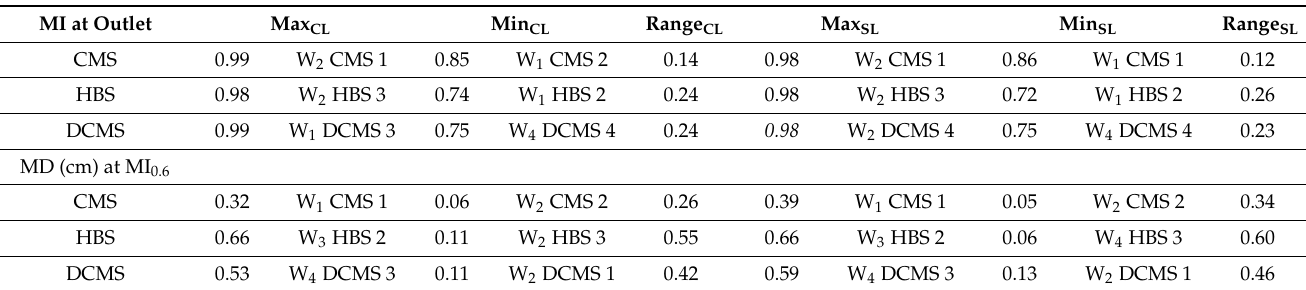
Table A1. Range in MI found at the outlet (1 cm) and the mixing distance (MD) required to obtain a mixing index of 0.6. The max and min values (and which design these represent) are presented for the channel layers (CL) and the surface layer (SL), as well as the range. Represented are the two design families compared in this article, CMS and DCMS, as well as a previously studied herringbone-type structure (HBS) presented in our previous article